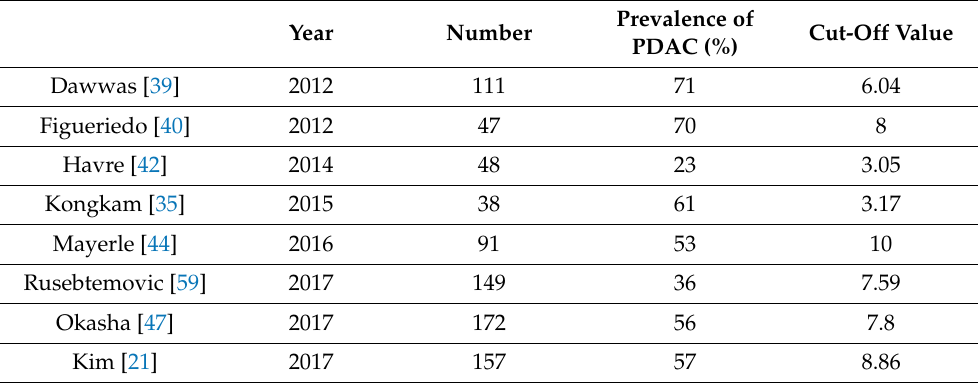
Table 4. Usefulness of the strain ratio in pancreatic solid